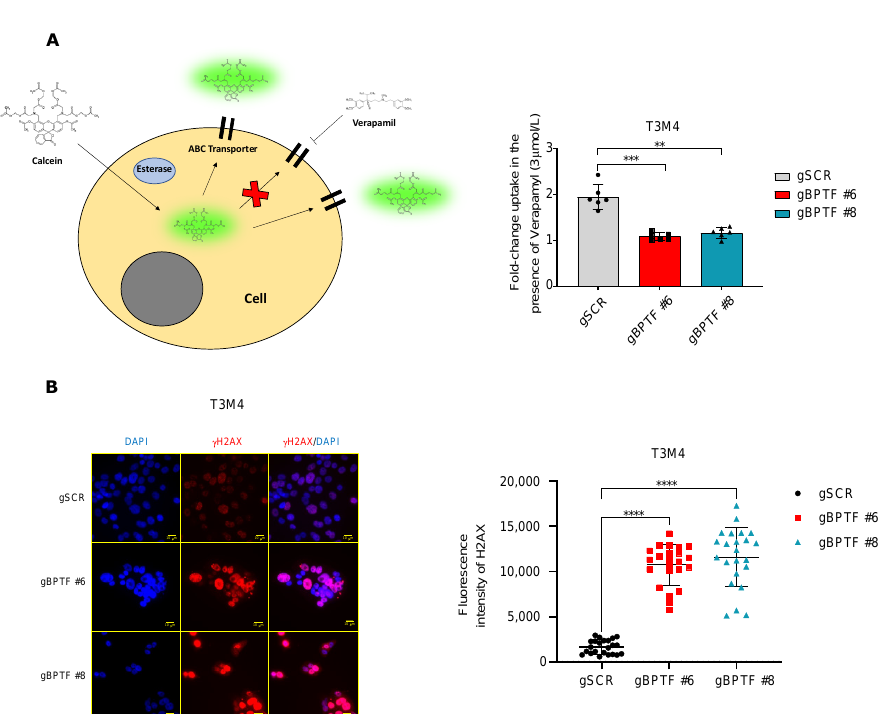
Figure 6. BPTF-silencing enhances gemcitabine action by increasing DNA damage. ( A ) Representative image of calcein-AM uptake as well as processing and export in the presence or absence of Verapamil. Fold change uptake of calcein in the presence of Verapamil (3 µ mol/L) in T3M4 BPTF- interfered cells (gBPTF #6 and gBPTF #8) compared to non-targeted (gSCR); n = 3. ( B ) Representative images of immunofluorescence of γ H2AX staining and its quantification after 12 h of gemcitabine treatment (IC50) in T3M4 BPTF-interfered cells (gBPTF #6 and gBPTF #8) compared to non-targeted (gSCR); n = 6. Significance was considered for ** p < 0.01, *** p < 0.005, and **** p < 0.001, ns (not statistically significant).